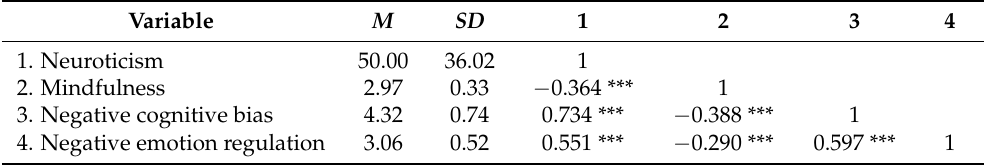
Table 1. Means, standard deviations, and